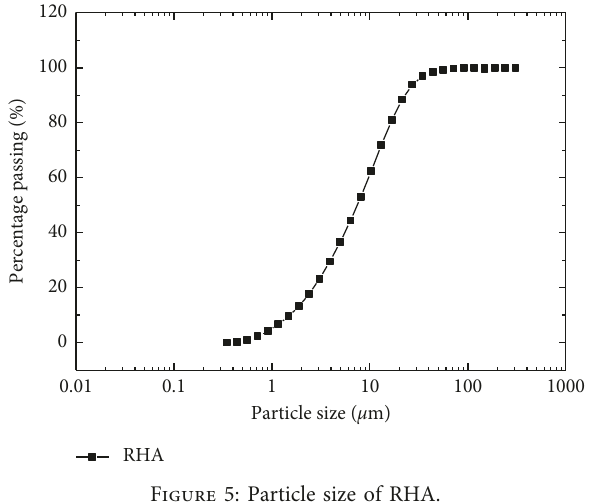
Figure 5: Particle size of RHA. Figure 6: Particle size of